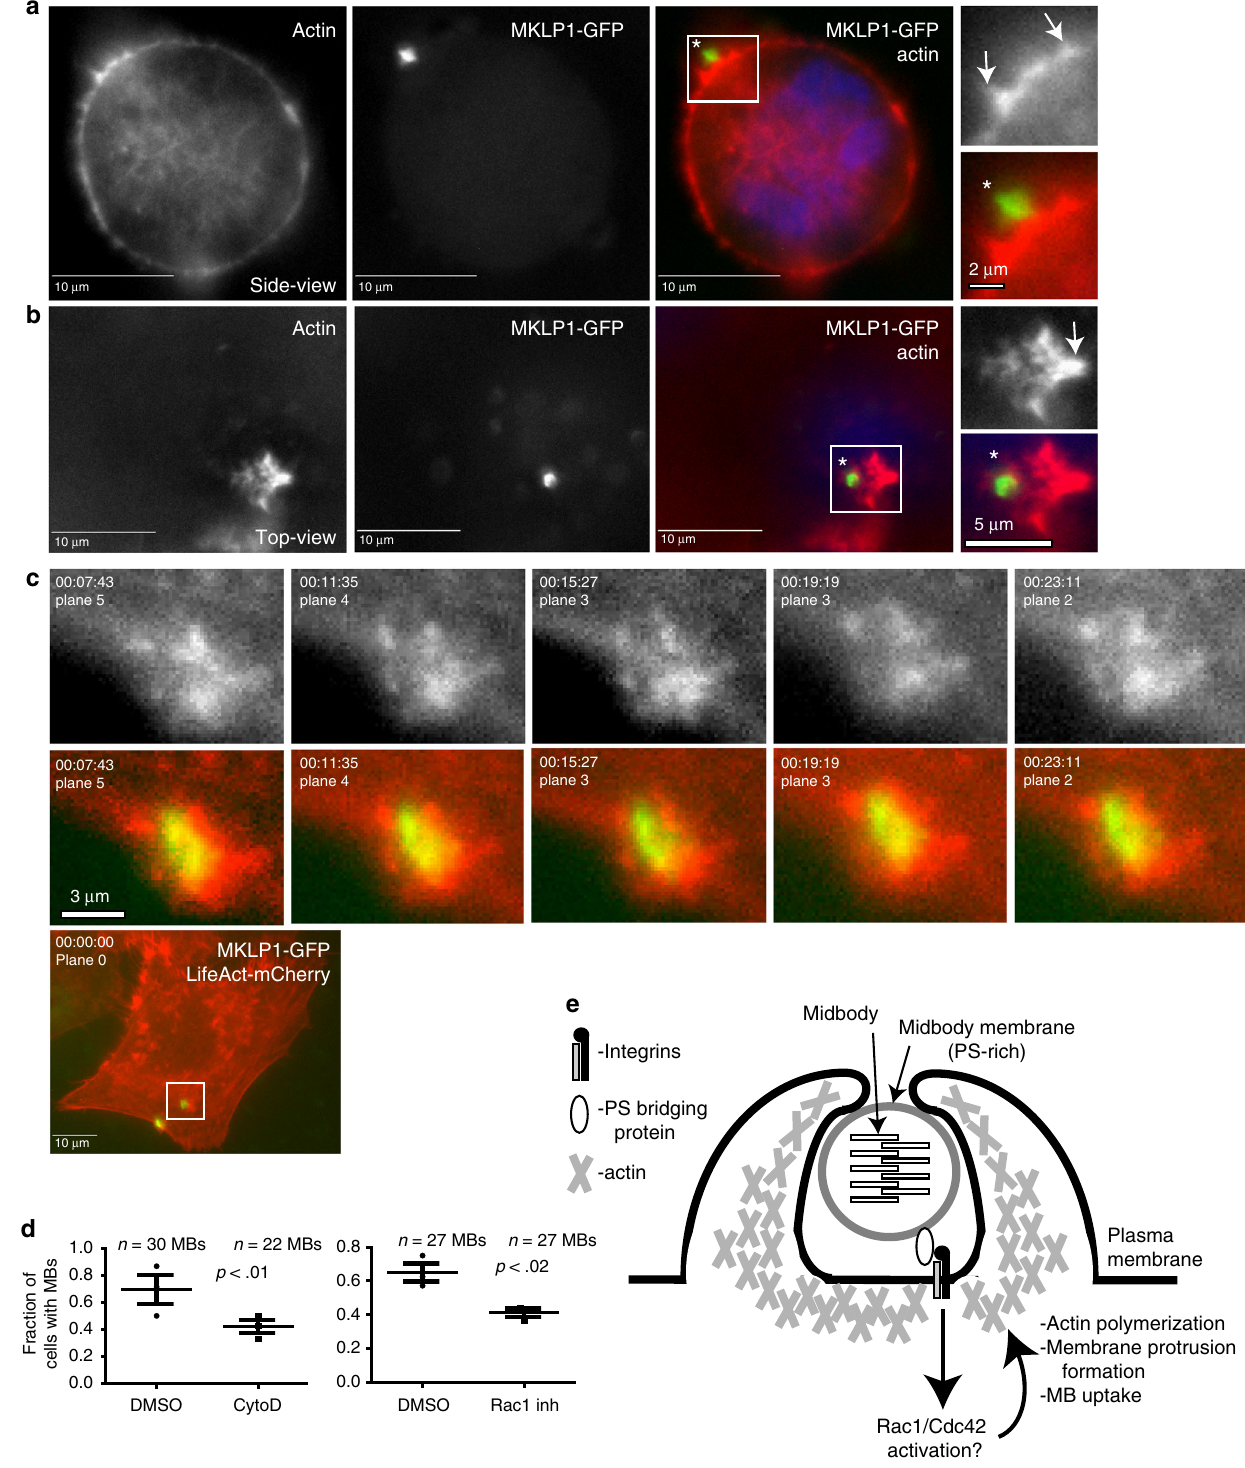
Fig. 4 Actin polymerization mediates phagocytic MB internalization. a – c HeLa cells stably expressing LifeAct-mCherry were incubated with GFP-MBs for 3 h. Cells were then washed and analyzed by microscopy. Arrows in a and b point to actin-rich protrusions surrounding MBs during internalization. c Shows time-lapse series of actin rosette dynamics during MB internalization. d HeLa cells stably expressing LifeAct-mCherry were incubated with GFP-MBs for 3 h in the presence or absence of 10 μ m of cytochalasin D or 100 μ m of Rac1 inhibitor. Cells were then washed and incubated for another 24 h (without cytochalasin D or Rac1 inhibitor). The number of cells with internalized post-mitotic MBs were determined by fl uorescence microscopy. The data shown are means and standard deviations derived from three independent experiments. n shows the number of cells analyzed for each experimental condition (Student ’ s unpaired, two-tailed t -test). e Schematic representation of proposed mechanism for MB